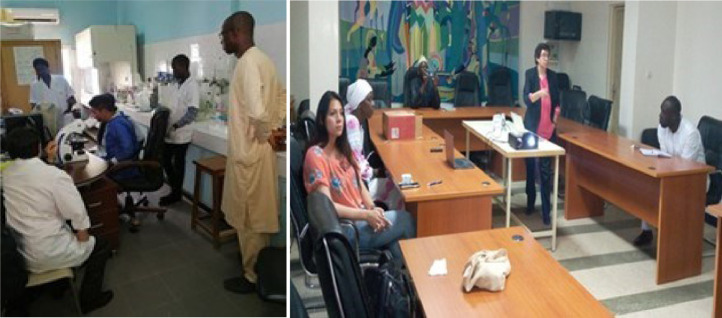
LATEU Laboratory.